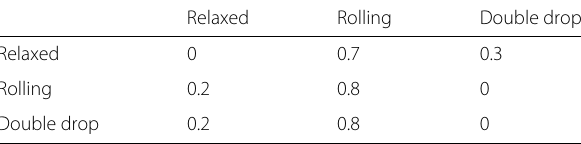
Table 3 Transition matrix controlling the transition type